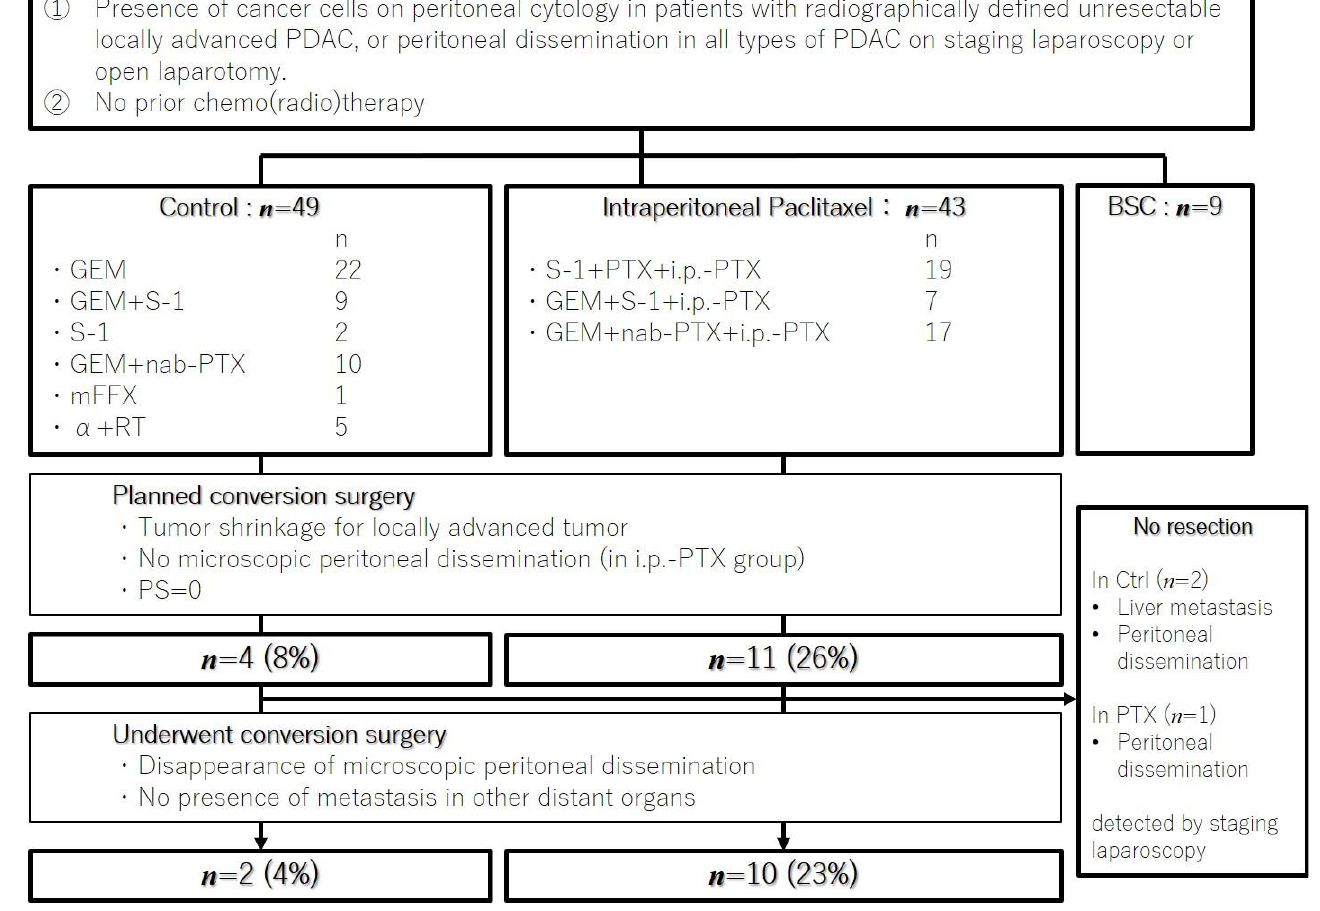
Figure 1. Flowchart of case selection. GEM, gemcitabine; nab-PTX, nab-paclitaxel; α, gemcitabine or S-1; RT, radiotherapy; mFFX, modified FOLFIRINOX; i.p.-PTX, intraperitoneal paclitaxel; PS, performance status; Ctrl, control; BSC, best supportive care.